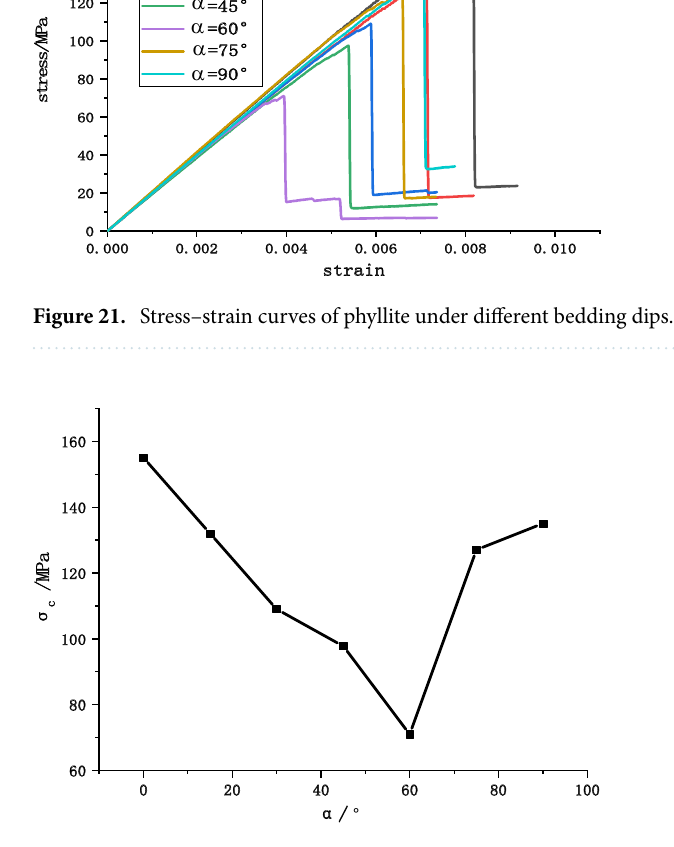
Figure 22. Peak stress-bedding inclinations curve.